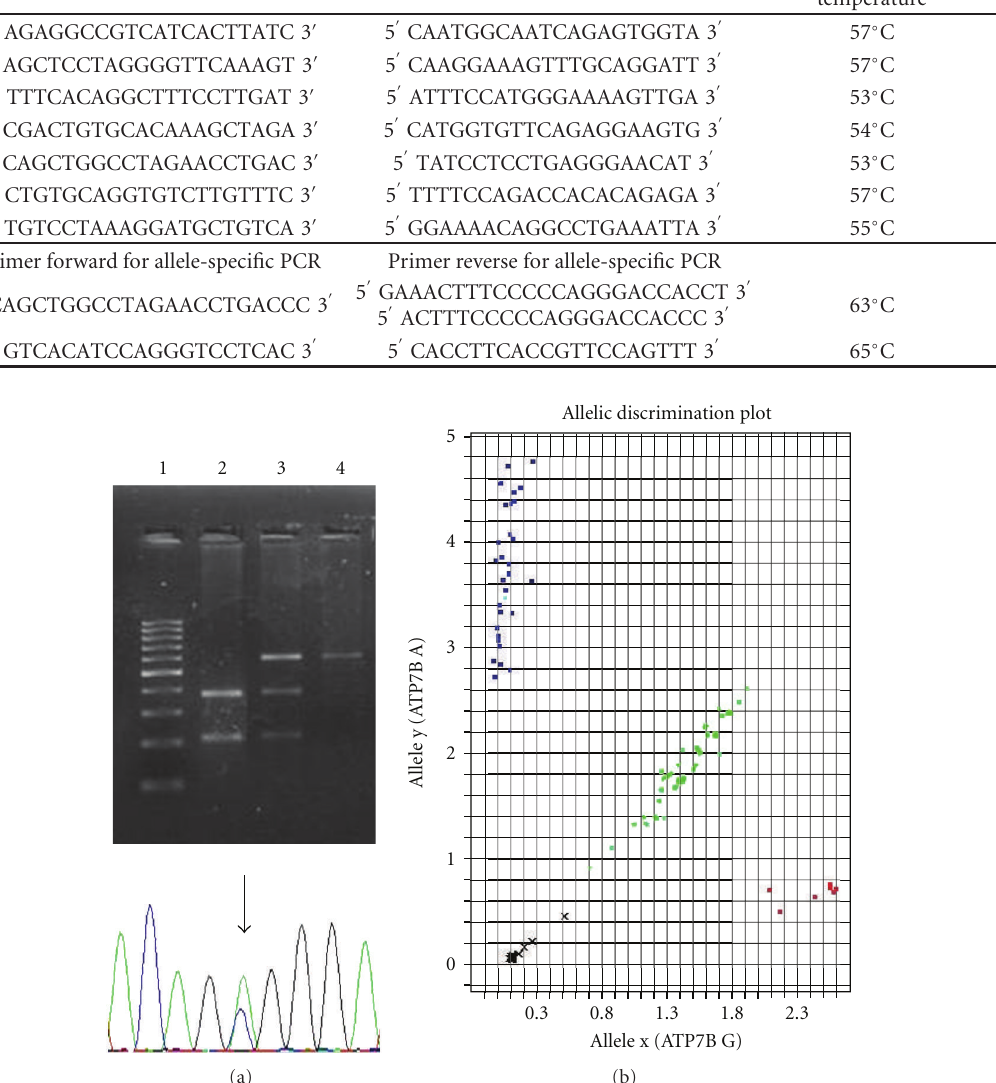
Figure 1: Analytical procedures for ATP7B SNPs detection. (a) PCR-restriction fragment length polymorphism (RFLP) assay for detection of c.1216 T > G SNP. Lane 1: PCR 100bp low ladder. Lane 2:GG genotype (375bp and 209bp RFLP). Lane 3:TG genotype (584bp,